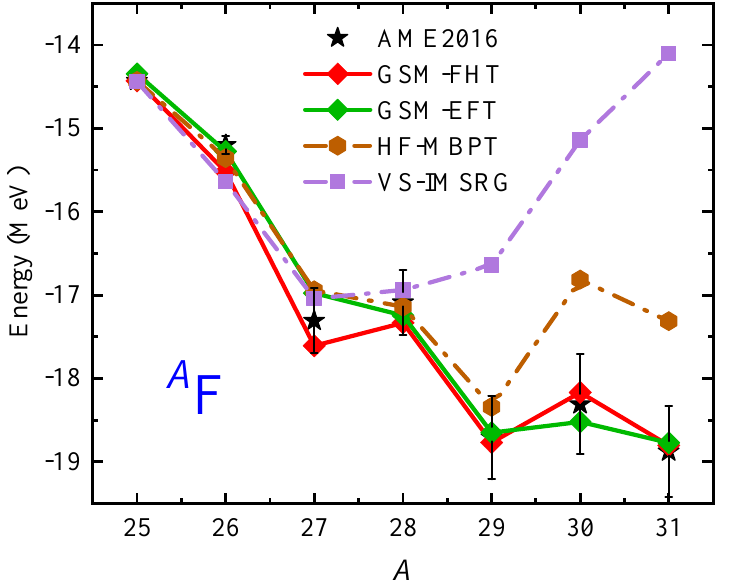
Figure 6. Energies of 25 − 31 F with respect to the 24 O core, calculated within different theoretical frameworks and compared to experimental data [78]. Besides the GSM calculations using FHT and EFT interactions, calculations in the Hartree-Fock many-body perturbation theory (HF-MBPT) [88] and VS-IMSRG [84] frameworks, utilizing the harmonic-oscillator (HO) basis, hence being without continuum coupling, are presented (with permissions from Ref.